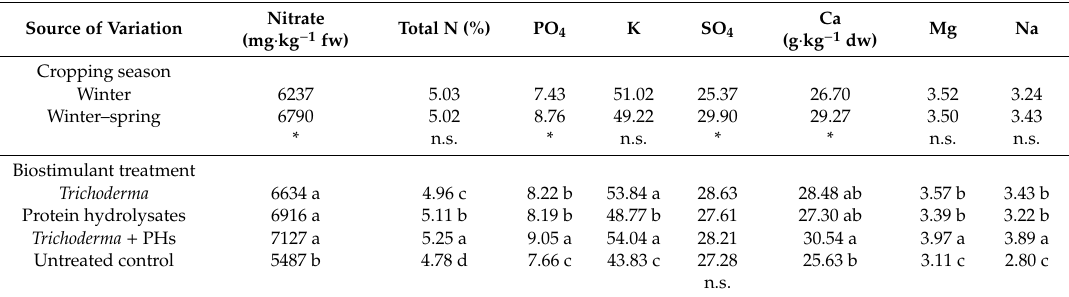
Table 4. The influence of cropping season and biostimulant applications on perennial wall rocket leaf mineral